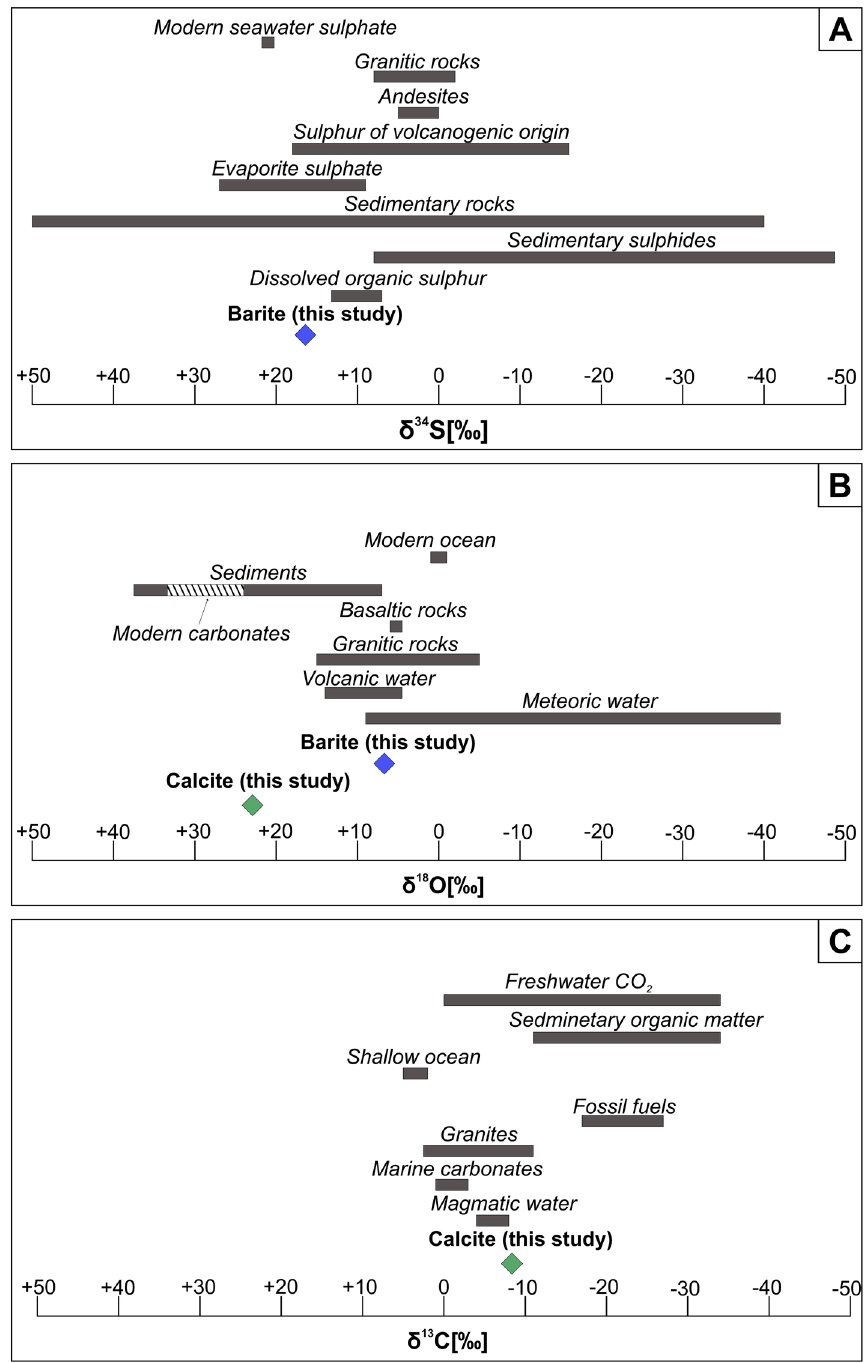
Figure 12. Distribution of δ 34 S ( A ), δ 18 O ( B ), and δ 13 C ( C ) in barite and calcite from Jebel Quichane in relation to various geological reservoirs; data after 48,60–68